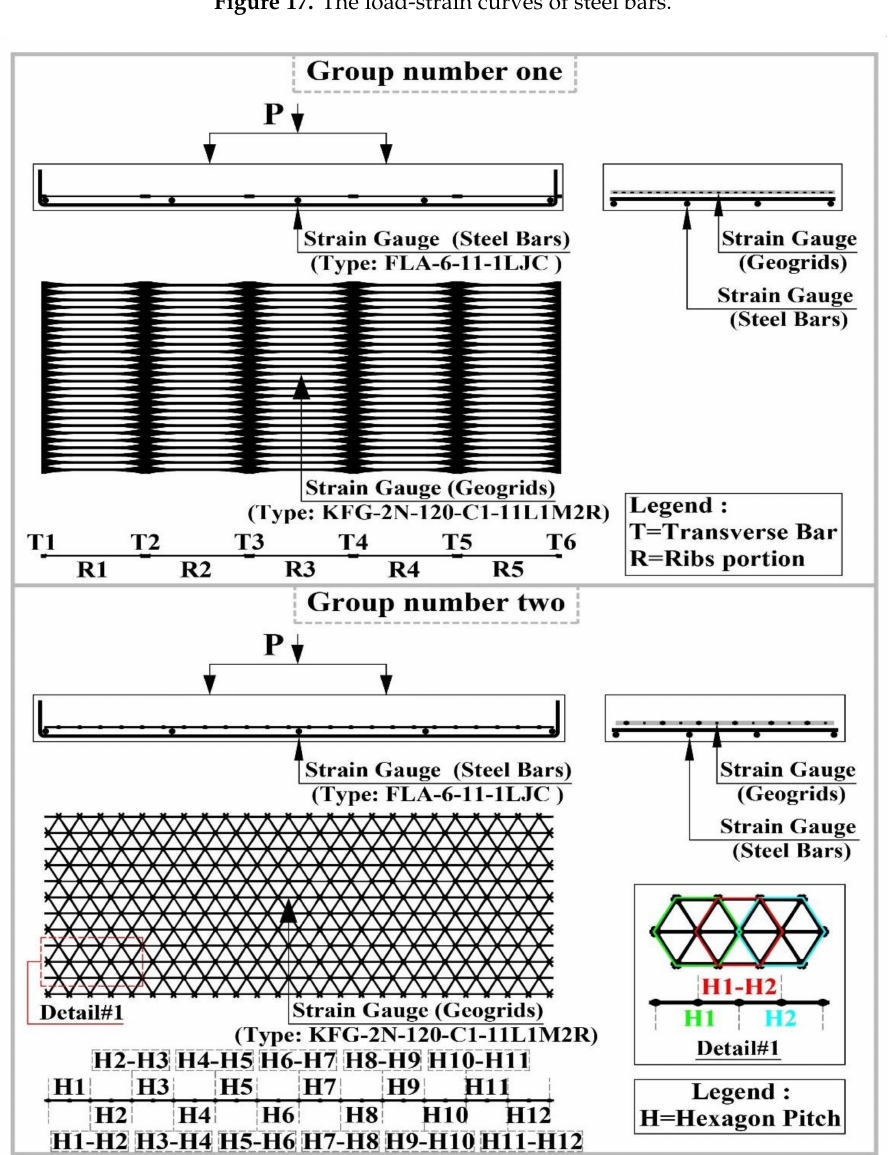
Figure 18. The bottom reinforcement general arrangement, the strain gauges’ locations, the uniaxial geogrids’ ribs portions, and transverse bars numbering system, and the triaxial geogrids’ hexagon pitches numbering